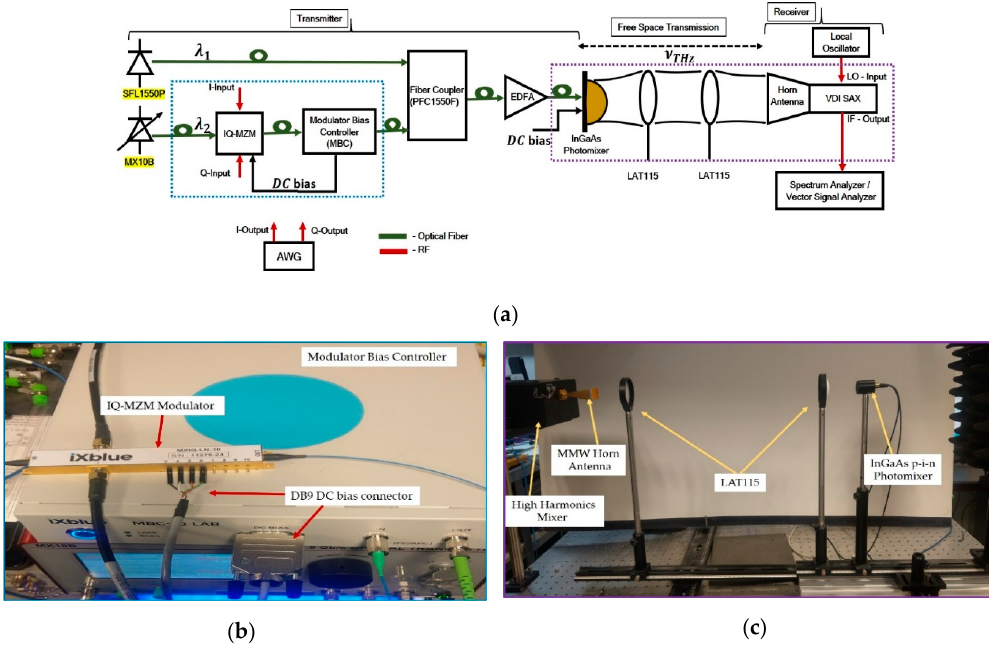
Figure 3. Experimental set-up. ( a ) Proposed MMW wireless communication link based on InGaAs p-i-n photomixer and receiver. ( b ) IQ-MZM modulator and the Modulator Bias Control (MBC). ( c ) The free space transmission overview.